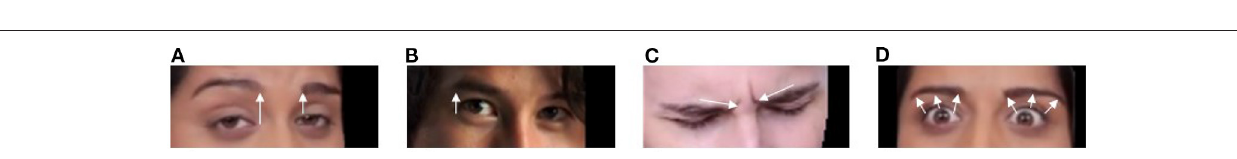
FIGURE 2 | Examples of the four Action Units (AUs) investigated in this study, taken from the aligned faces extracted by OpenFace: (A) AU01 (inner brow raiser, measured intensity: 2.51); (B) AU02 (outer brow raiser, measured intensity: 1.06); (C) AU04 (brow lowerer, measured intensity: 3.46); (D) AU05 (upper lid raiser, measured intensity: